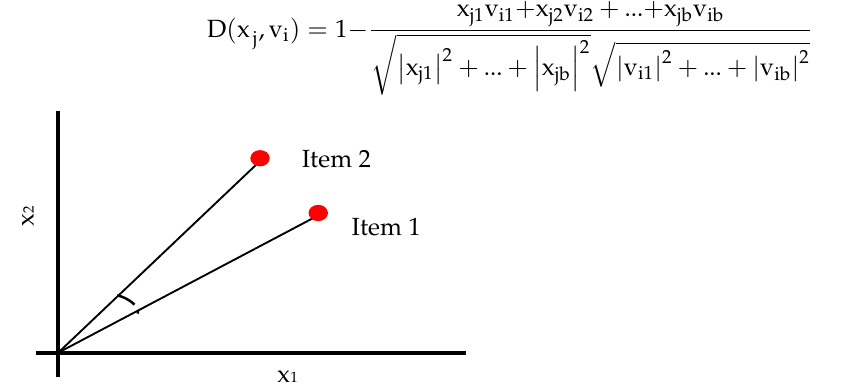
Figure 3. Schematic Diagram of Correlation Distance Measures.